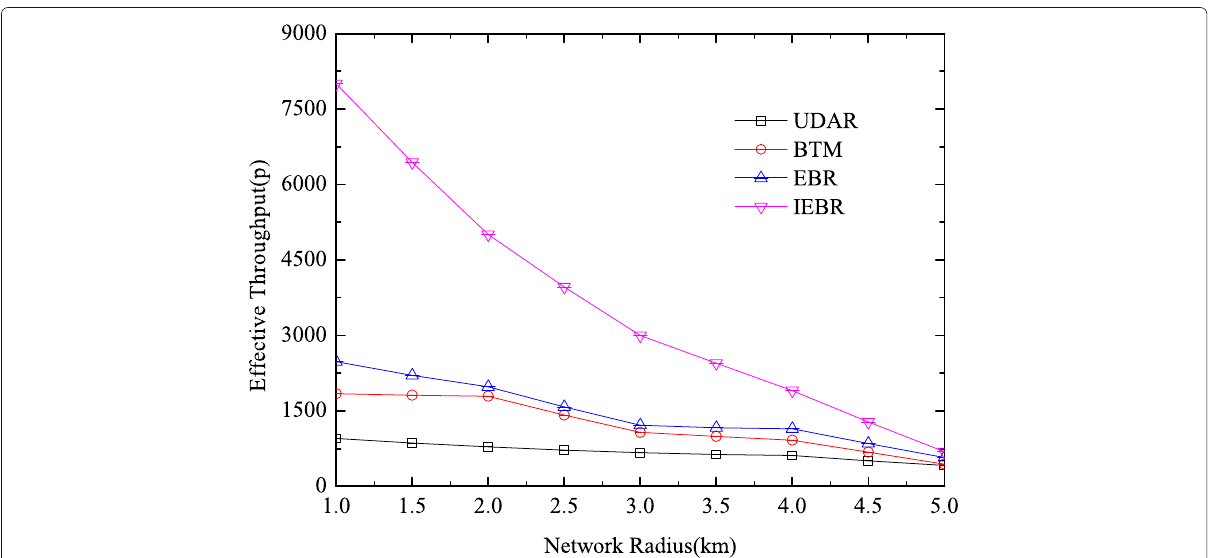
Fig. 10 The effective throughput with different network radiuses